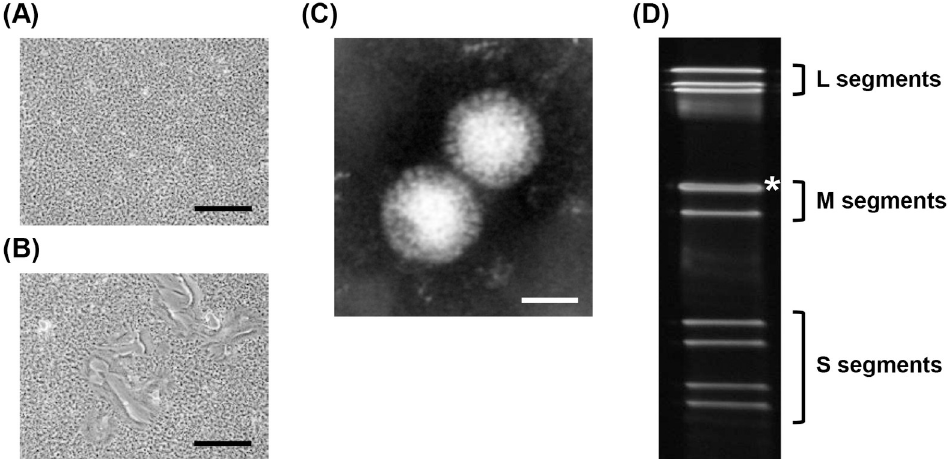
Fig 1. Isolation of PRV from bat colon specimen. (A and B) Phase-contrast images of mock-infected (A) and bat colon specimen–inoculated Vero E6 cells (B) at 5 dpi. CPE represented by syncytium formation was observed in Vero E6 cells inoculated with the bat colon specimen. Scale bar, 500 μ m. (C) Electron micrograph of the virus isolated from the bat colon specimen. Scale bar, 50 nm. (D) Electropherotypes of viral dsRNA extracted from the isolated virus were observed by SDS-PAGE using 4–15% gradient gel. The locations of three L segments, three M segments, and four S segments are indicated. The M1 and M2 segments were considered to have co-migrated, forming a single band ( � ).